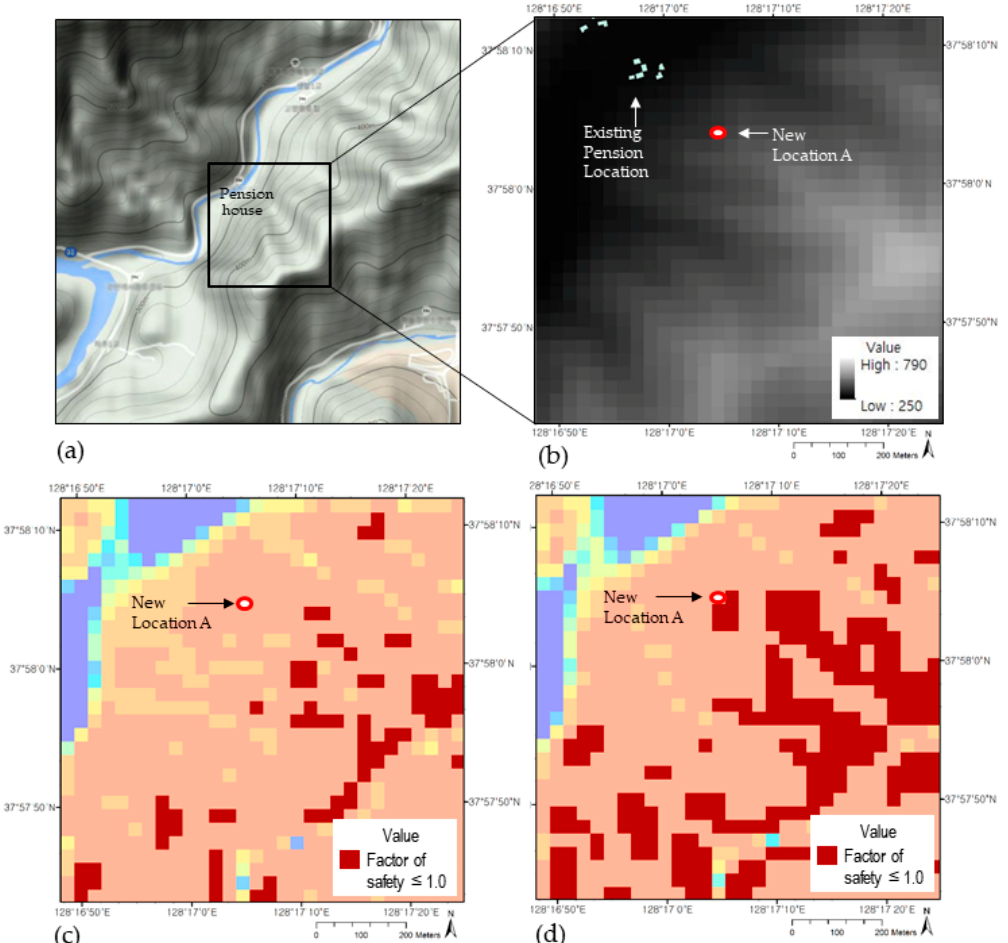
Figure 6. The case study site and the results of TRIGRS modeling: ( a ) the site location; ( b ) topography of the site; ( c ) TRIGRS modeling result—200 mm for 48 h; ( d ) TRIGRS modeling result—800 mm for 24 h.